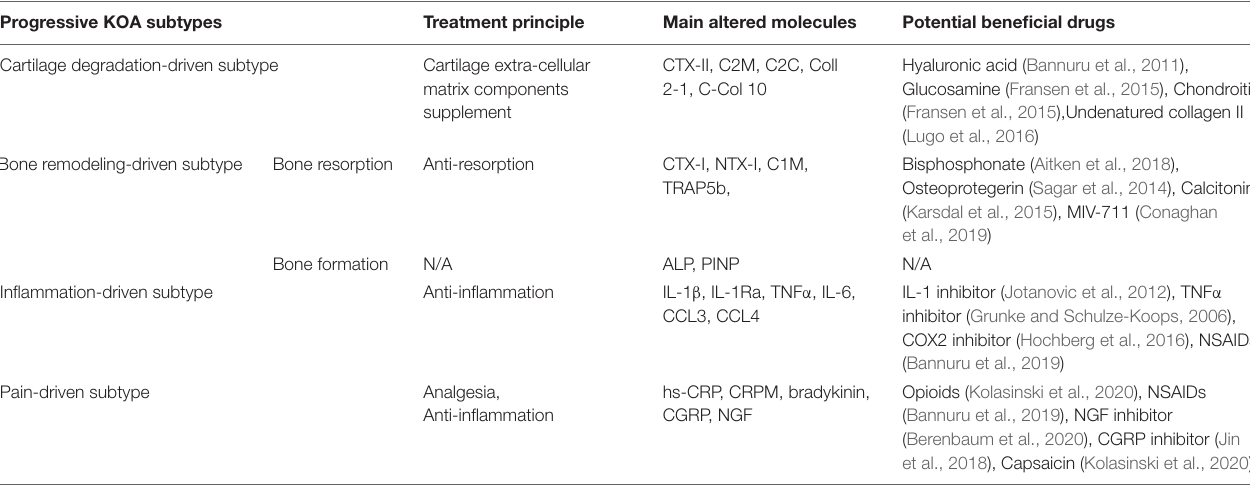
TABLE 2 | Potential beneficial treatment options for progressive KOA